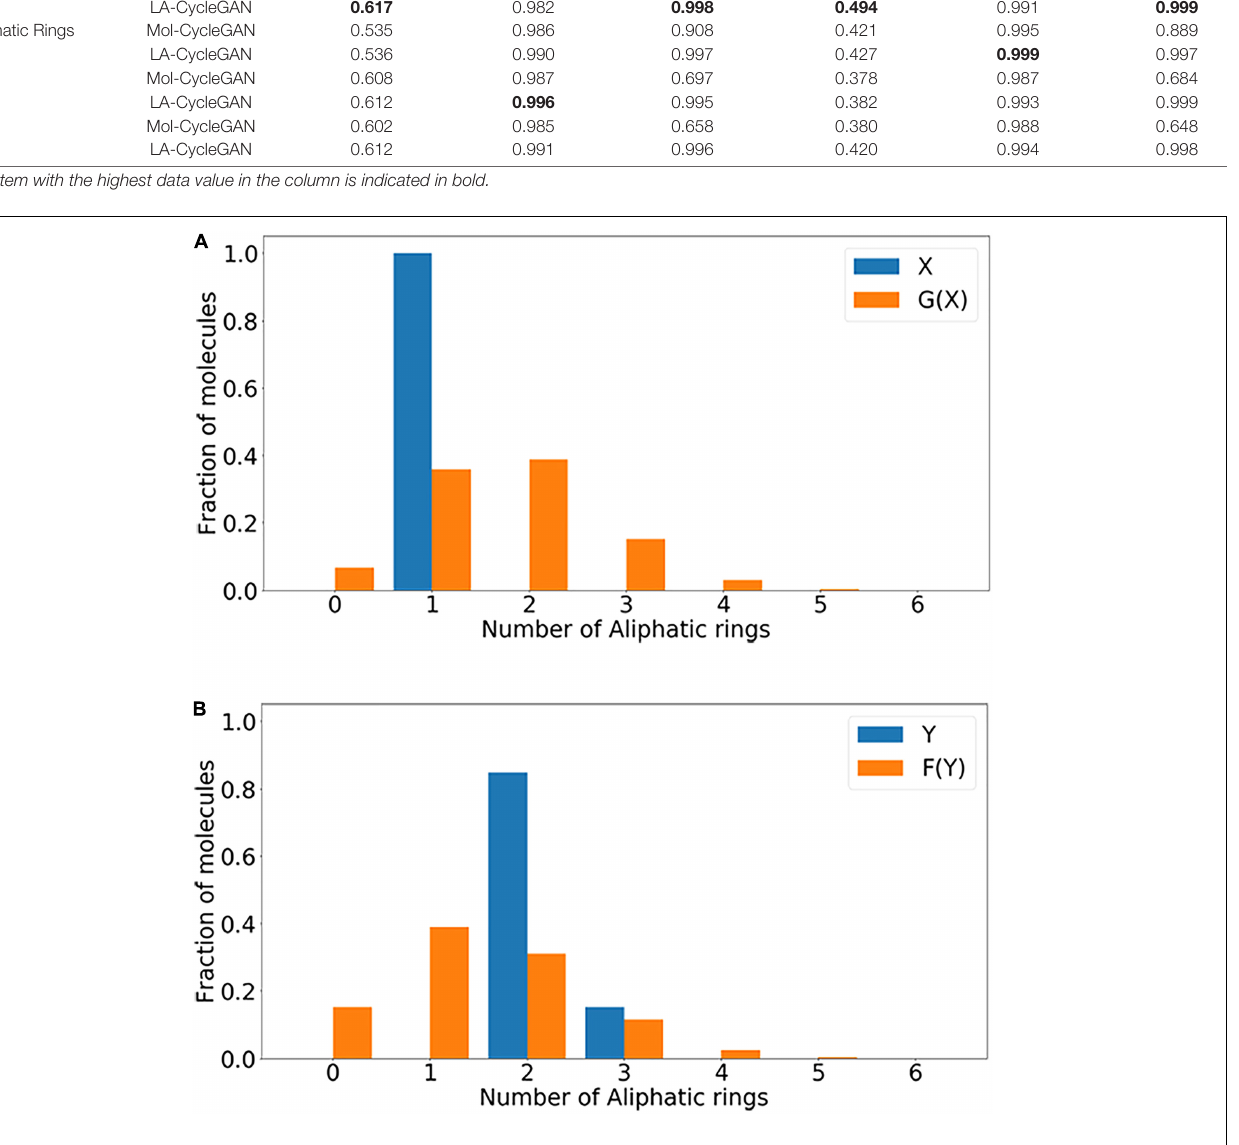
Frontiers in Genetics |